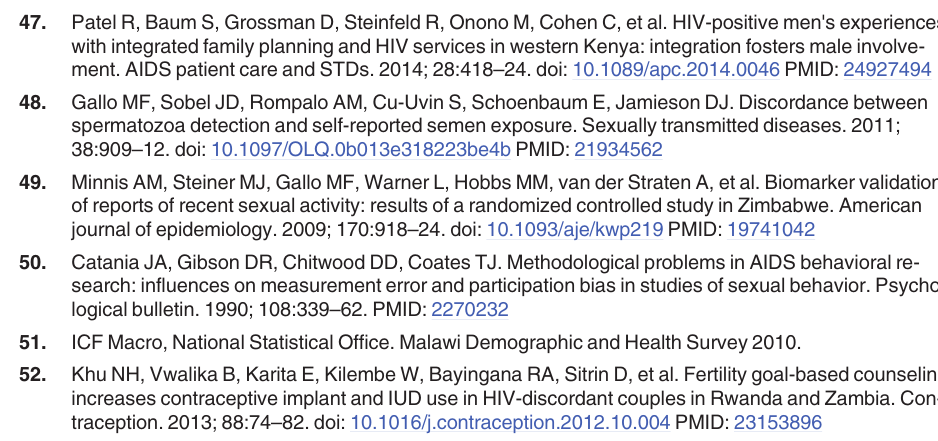
PLOS ONE | DOI:10.1371/journal.pone.0121039 March 26,